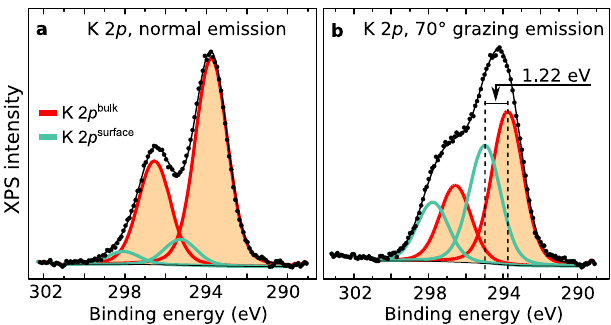
Fig. 2 | XPS spectra ofK+ions onUHV-cleavedmica. XPS data(blackpoints)and fi tted curves (solid lines) of the K 2 p core levels (Al K α , pass energy 20eV). a , b Spectra taken in normal and 70° grazing emission, respectively. Two sets of K 2 p components fi t the spectra, assigned to K residing in the bulk (orange) and on thesurface(green).Thebindingenergyaxeswereadjustedtoaccountforcharging (see “ Methods ”